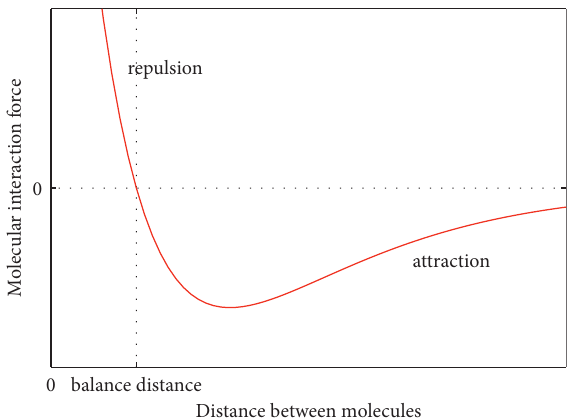
Figure 1: The molecular spacing and their